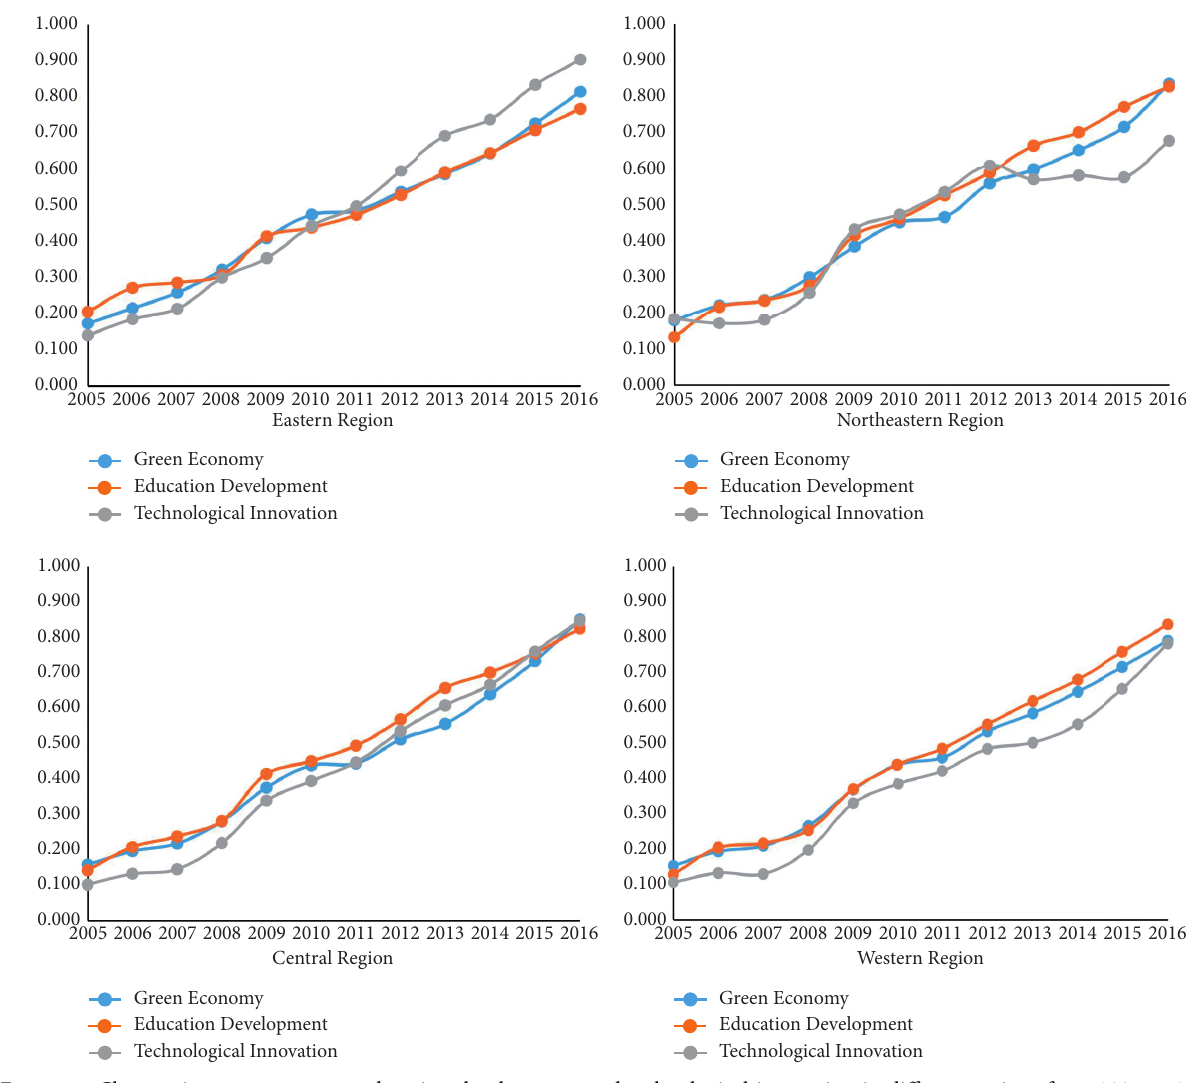
Figure 1: Changes in green economy, education development, and technological innovation in different regions from 2005 to